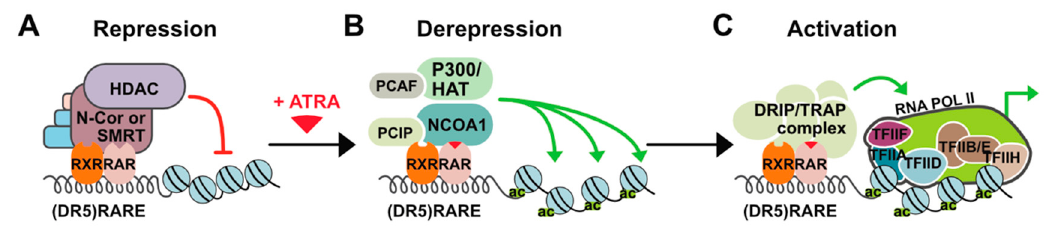
Figure 1. Mechanism of all-trans-retinoic acid (ATRA) action. ( A ) In the absence of a ligand, retinoid X (or rexinoid) receptors and retinoic acid receptors (RXR-RAR) heterodimers bind to retinoic acid response elements (RAREs) in the regulatory regions of target genes and repress transcription through recruiting histone deacetylases (HDAC)/co-repressor (negative co-regulator (N-CoR) or silencing mediator for retinoid and thyroid hormone receptors (SMRT)) complexes. HDACs remove acetyl groups from nucleosomal histones causing chromatin condensation that precludes binding of other factors and ultimately results in the silencing of gene expression. ( B ) Upon ligand binding, RAR undergoes structural change leading to dissociation of the co-repressor complex and association of co-activators with histone acetyltransferase (HAT) activities (e.g. P300 and NCOA1) that cause decondensation of chromatin by adding acetyl groups to nucleosomal histones. ( C ) Additional multiprotein complexes called vitamin D3 receptor-interacting proteins or thyroid hormone receptor-associated proteins (DRIP or TRAP) may also be recruited for activation of transcription through interaction with basal transcriptional.